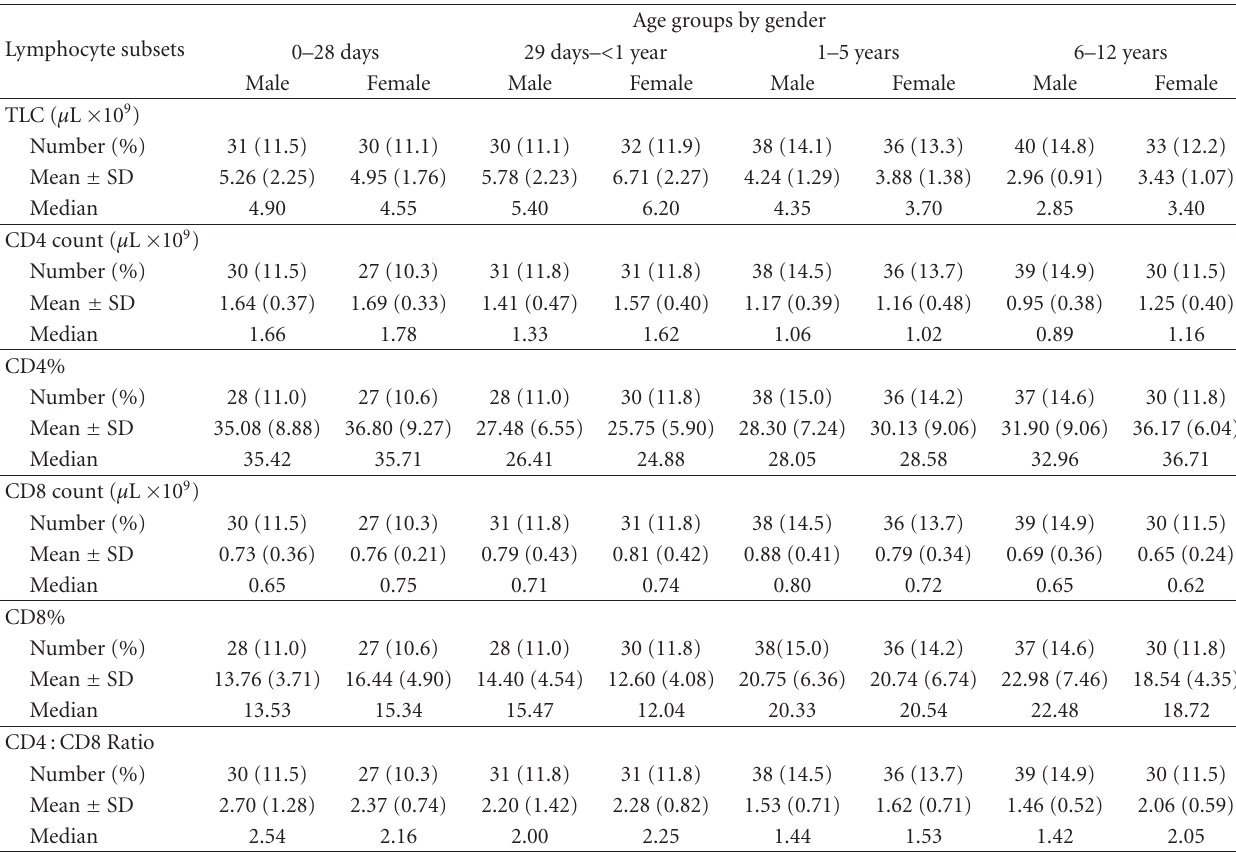
Table 2: Distribution of T-lymphocyte subsets by gender and age group.